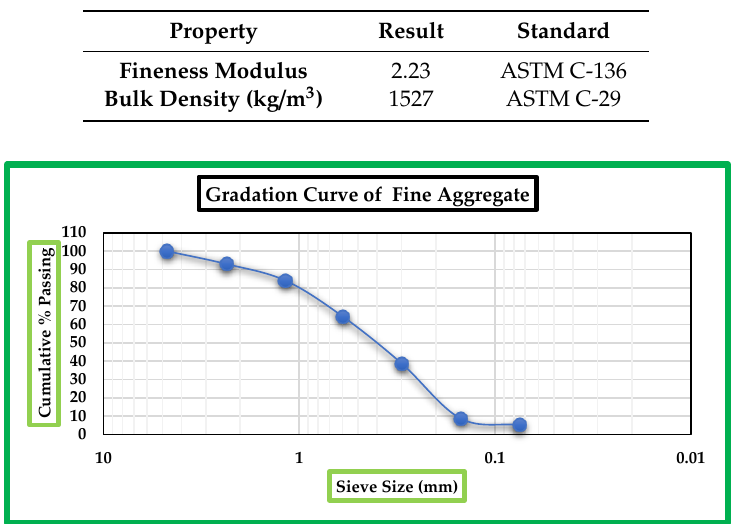
Table 2. Physical properties of ordinary Portland Cement.